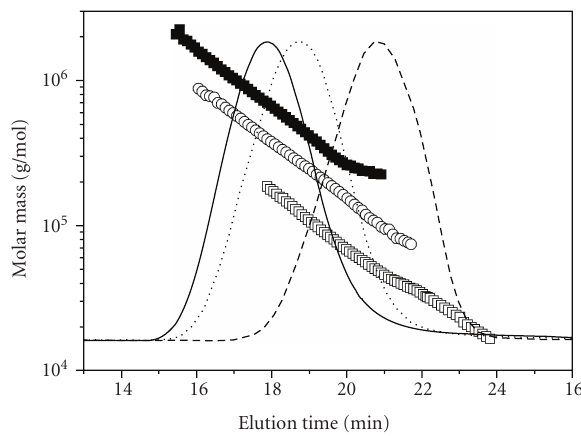
Figure 1: Light scattering chromatograms (lines) and molar mass versus elution time plot (symbols) from SEC-MALS analysis for 52kDa HA preparation (dashed line, (dotted line, (cid:3) ), and 970kDa preparation (solid line,